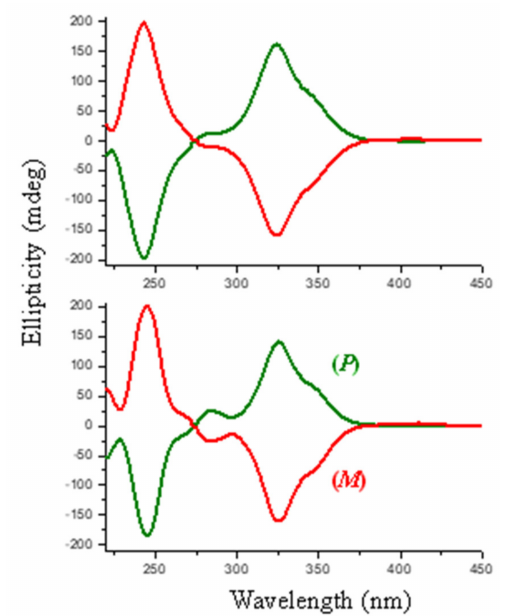
Figure 4. CD spectra of the enantiomers of 4 (top) and 5-aza-[6]-helicene (bottom) in